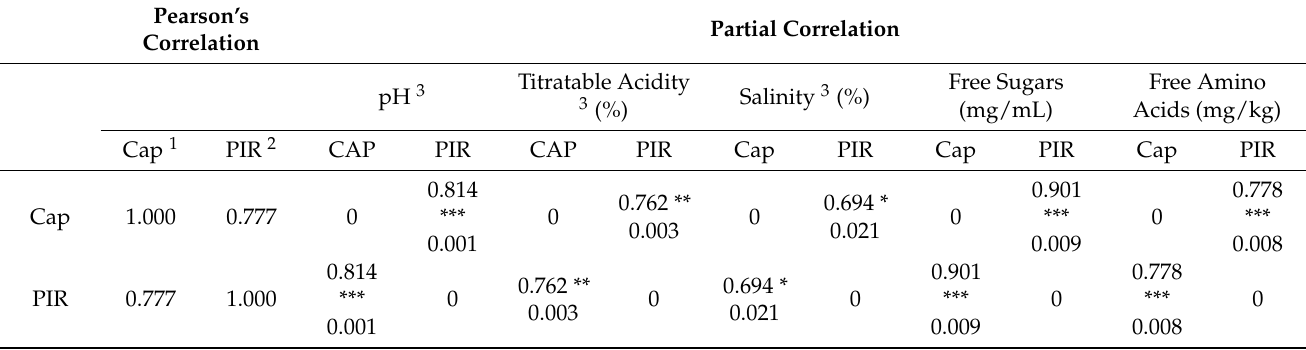
Table 4. Partial correlation coefficients showing the relationships among physicochemical properties, capsaicin contents, and rating of spiciness